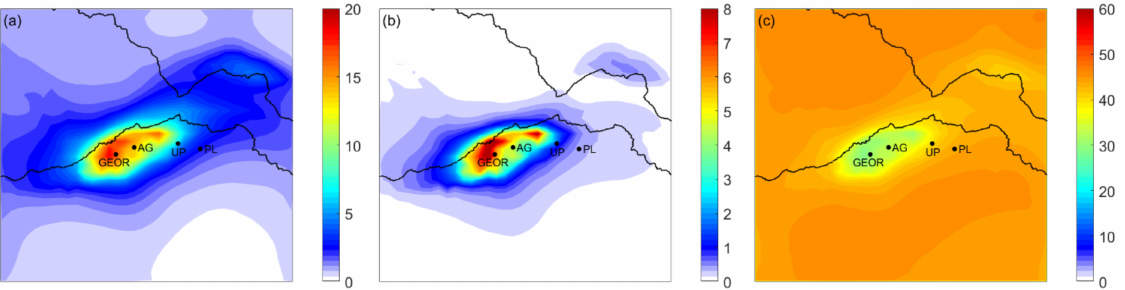
Figure 11. Predicted average ground concentrations (ppb) of ( a ) NO 2 , ( b ) NO and ( c ) O 3 during July 2021. Different scales are